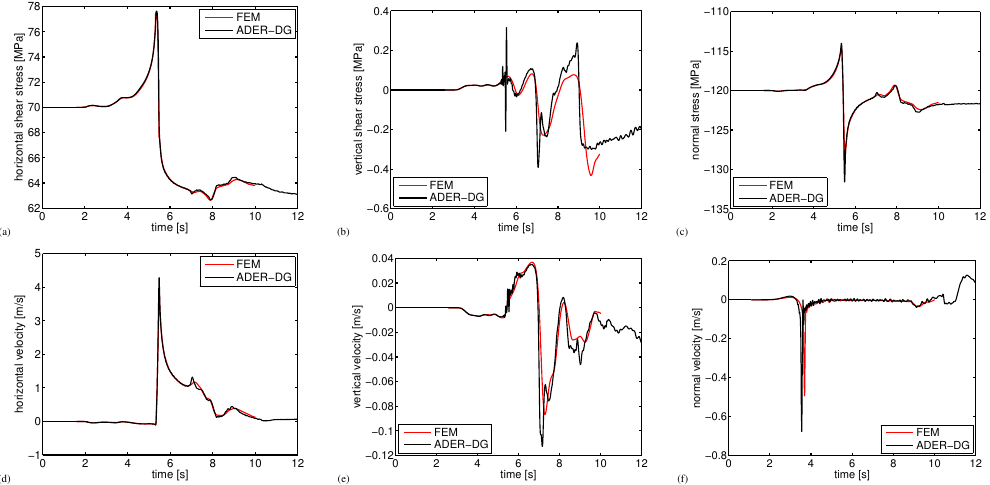
and above the hypocenter. The ADER-DG solution is shown in black, the FEM comparison solution in red.